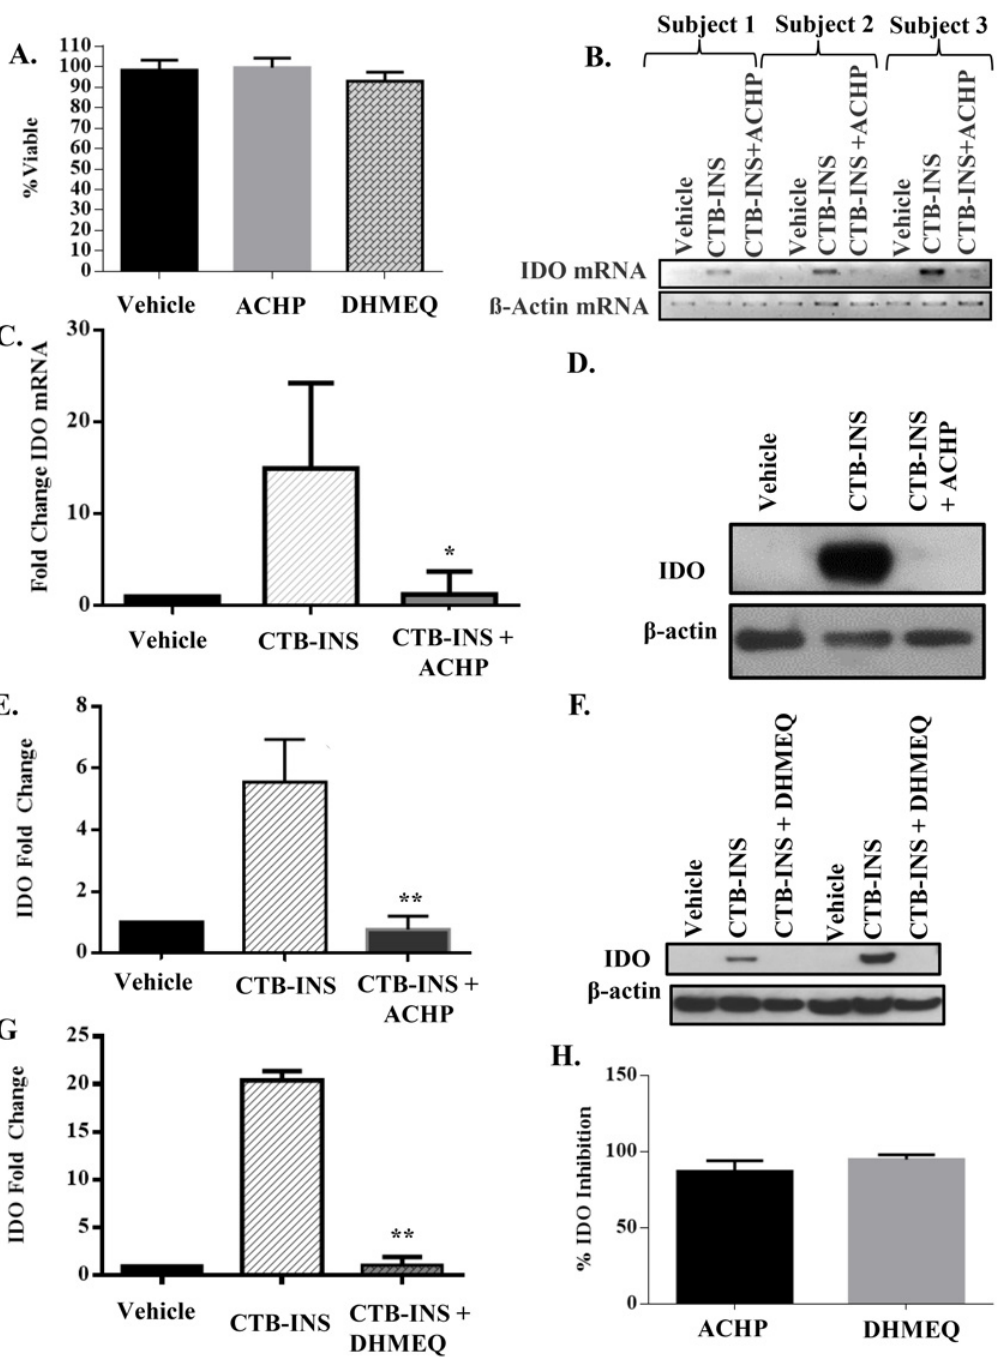
Fig 4. ACHP and DHMEQ inhibitors of NF- κ B block CTB-INS induced IDO1 biosynthesis. (A) Dendritic cell viability was measured by determination of the percentage of DCs negative for annexin V and propidium iodide following treatment with ACHP (500 nM) and DHMEQ (3 μ g/ml). The measurement of DC viability shows vaccinated DCs are unaffected by treatment with the inhibitors. (B, C) Agarose gel electrophoresis and graphic representation showing changes in IDO1 mRNA levels in DCs from three representative subjects determined by qRT-PCR after 3 hours incubation of subject monocyte derived DCs with CTB-INS (10 μ g/mL) or CTB-INS and ACHP. Statistical significance (p < 0.05) was achieved by analysis of a total of 5 subjects. (The vehicle used is the DMSO solvent in which ACHP and DHMEQ are dissolved). (D, E) Immunoblot and graphic representation of the fold change in IDO protein synthesized 24hrs after vaccine inoculation of subjects DCs inoculated with CTB-INS +/- ACHP. The experimental data was collected from five normal subjects, although only one representative subject is shown. Statistical significance between vaccine treated and vaccine + ACHP treated groups was measured by paired Student ’ s t test, (p = 0.0273). (F, G) Immunoblot and graphic representation of the fold change in IDO1 protein synthesized in subject DCs following